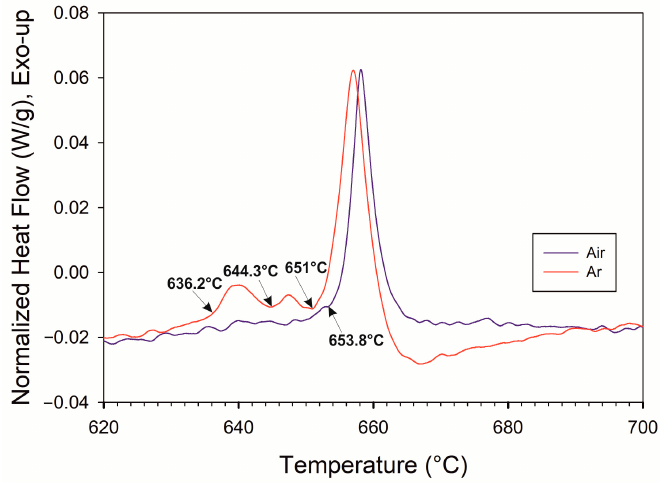
Figure 9. DTA measurement of CIP-ed green compact in air and in argon.